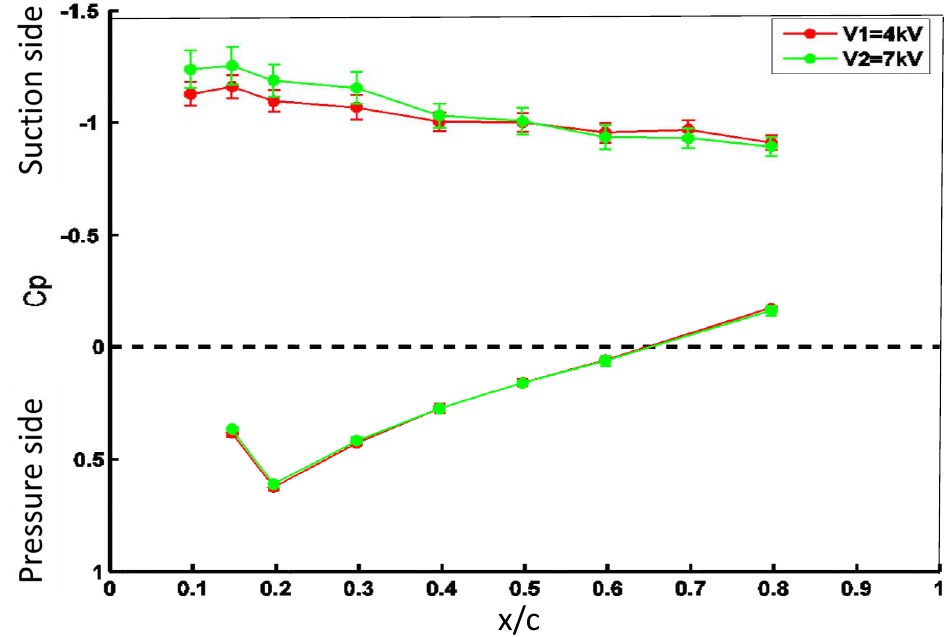
Figure 22. C p distribution comparing applied voltages at Re = 100,000 and α = 16 ◦ , and actuation frequency f = 66.6Hz.